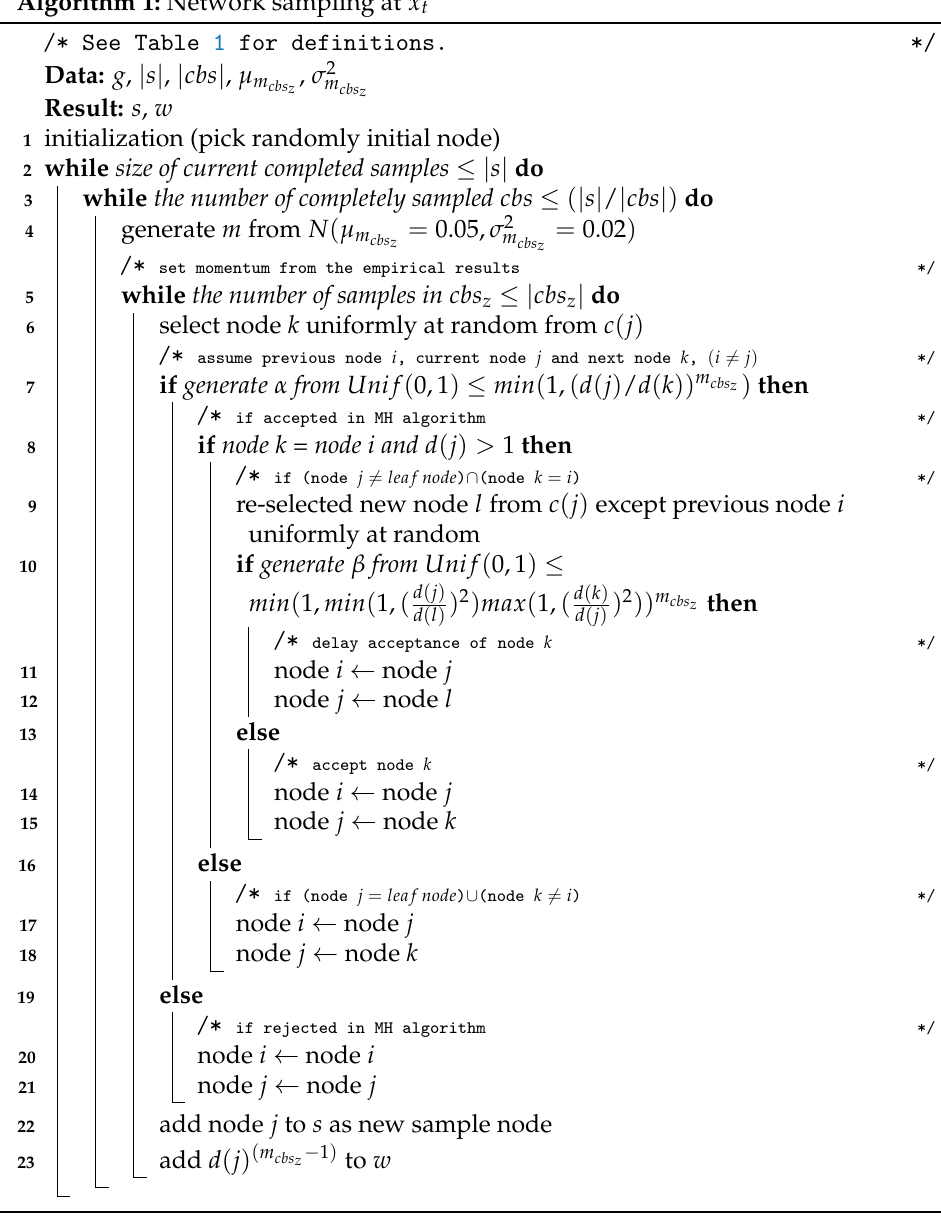
Algorithm 1: Network sampling at x